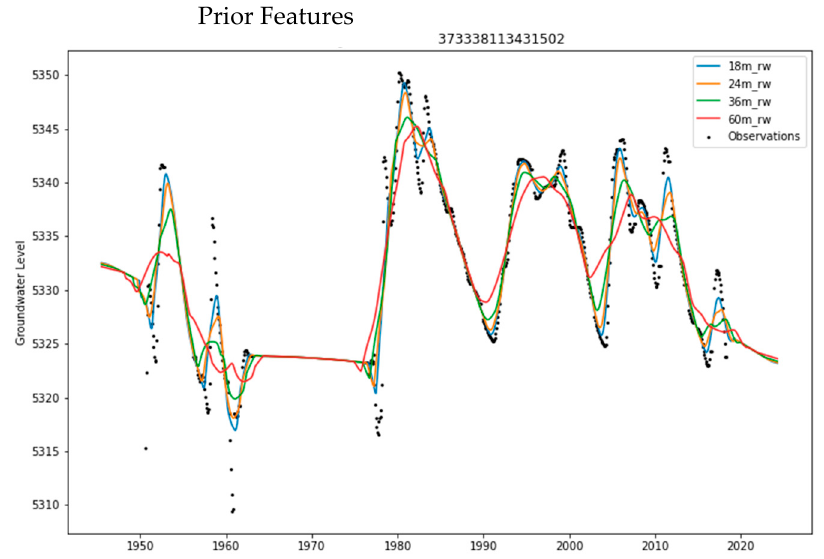
Figure 7. Prior features for groundwater trends for the generic well in Figure 5.